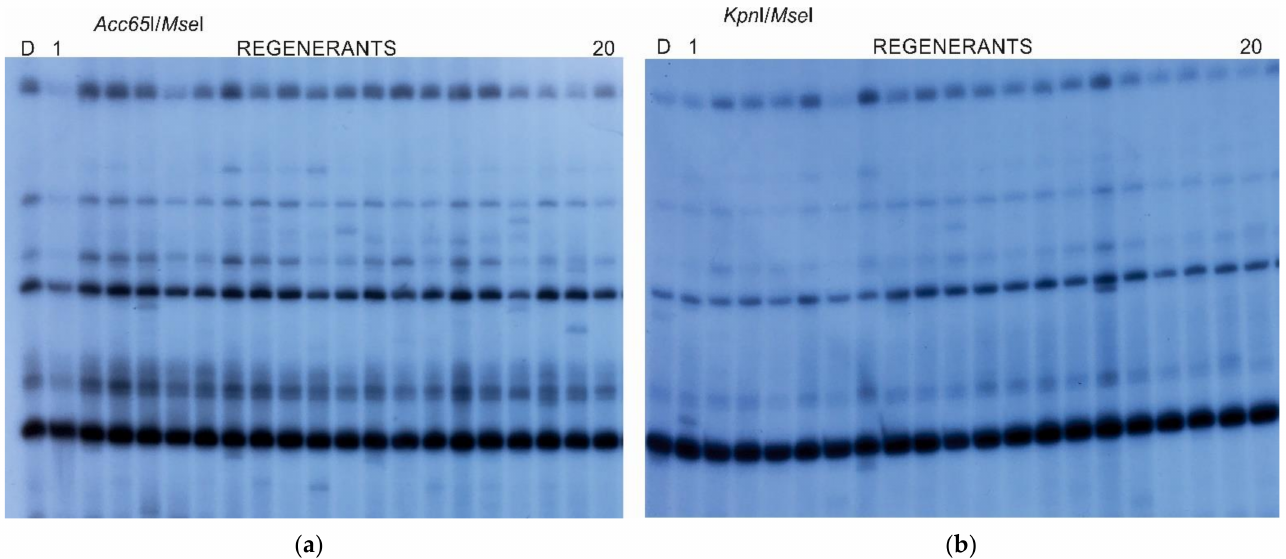
Figure 2. An example of Methyl-Sensitive Transposon Display (MSTD) profile generated with BAGY-1 -C2043 and CpG- GCA selective primers. The Acc65 I/ Ms eI ( a ) and Kpn I/ Mse I ( b ) reflected DNA profiles obtained with various restriction enzymes. Line D represents DNA profiles of the donor, lines 1–20 DNA profiles of the same regenerants obtained from different digestions.